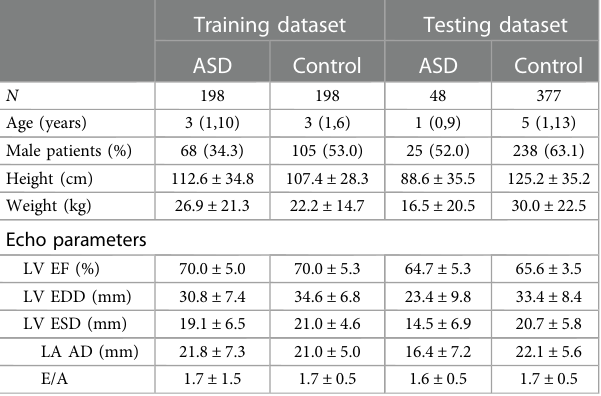
TABLE 1 Baseline characteristics of the training and testing dataset.